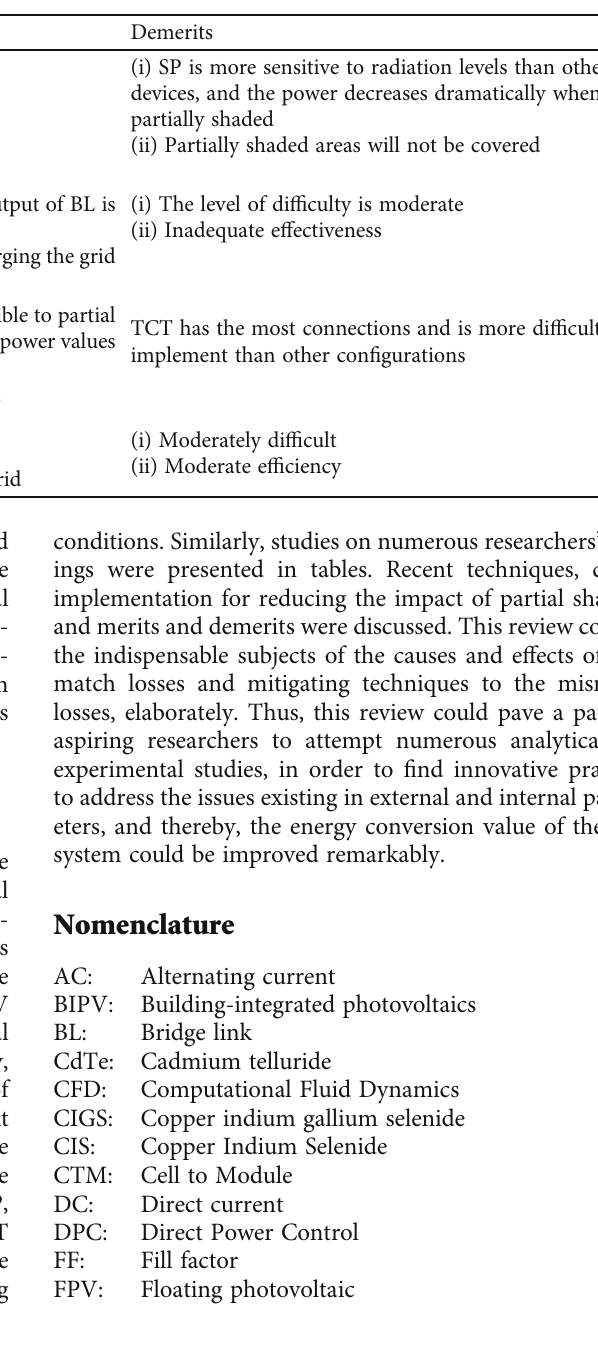
Table 8: Merits and demerits of various topological connections [165 – 169].